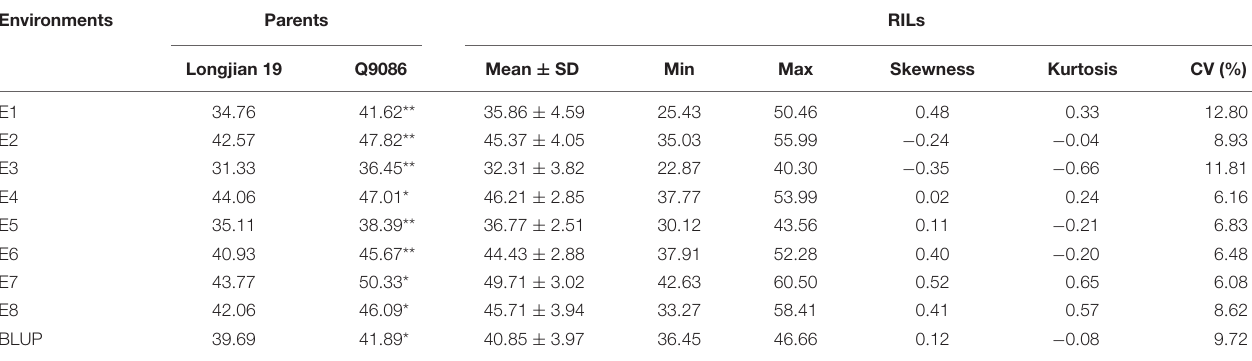
TABLE 1 | Summary statistics of TGW in the parents and the wheat RIL population under eight environments. Environments